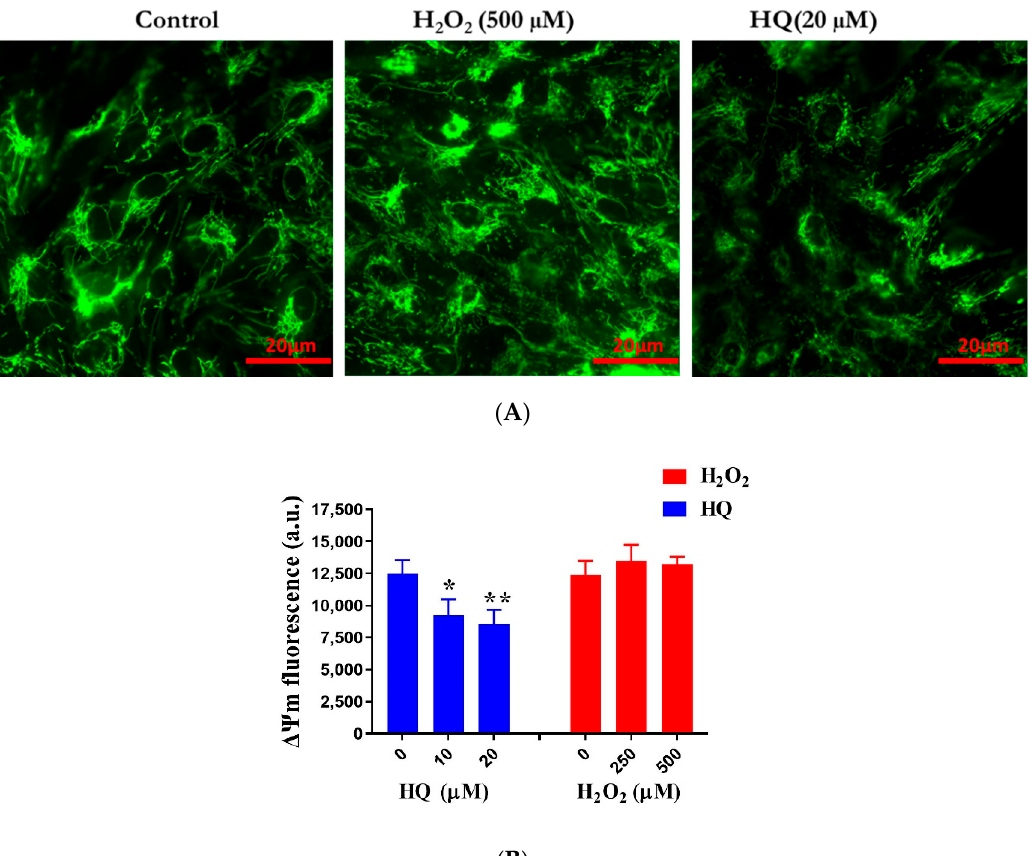
Figure 2. Effects of hydroquinone (HQ) and H 2 O 2 on mitochondrial morphology and mitochondrial membrane potential. ( A ) Live-cell fluorescence microscopy with the MitoTracker Green FM dye to determine changes in mitochondrial morphol- ogy in cells after incubation with HQ or H 2 O 2 for 2 h. ( B ) Measurement of mitochondrial membrane potential using TMRE dye in cells after treatment with HQ or H 2 O 2 for 2 h and using a fluorescence microplate reader at excitation/emission of 549 nm/575 nm. Data represent the mean (+standard deviation, SD) of 3 independent experiments of 3 replicates each. Statistical analysis was performed by one-way ANOVA followed by Dunnett’s multiple comparison tests. * p < 0.05, ** p < 0.01, significant difference relative to the controls. Arbitrary unit